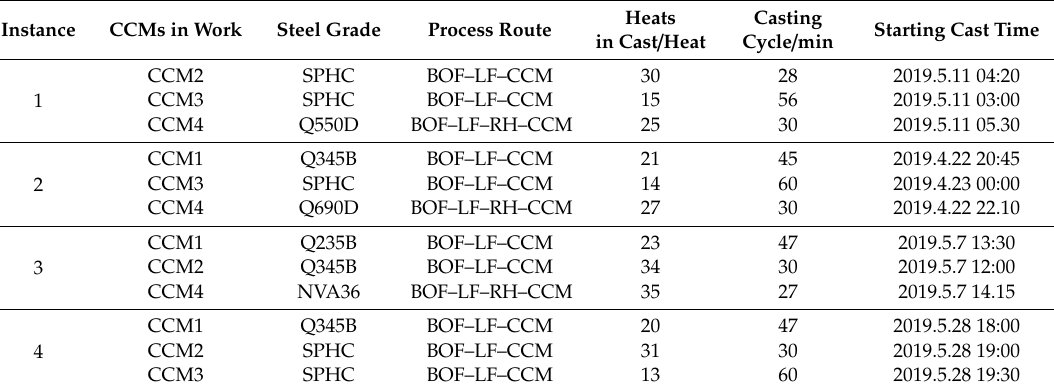
Table 4. Simulation instances for model